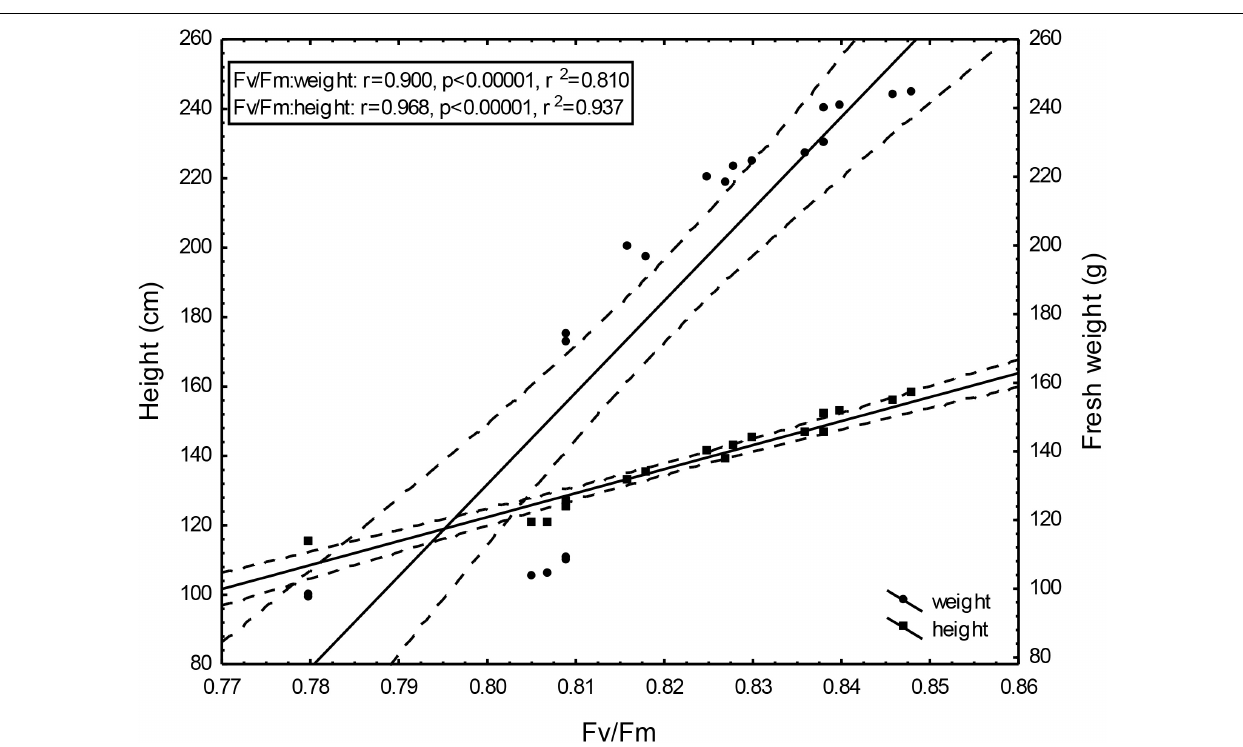
Frontiers in Plant Science |